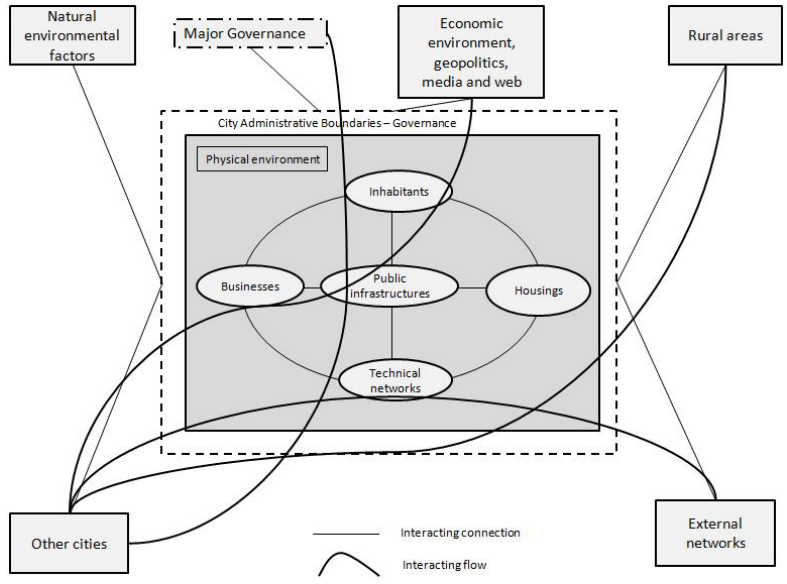
Figure 1. Functional block diagram for urban system.